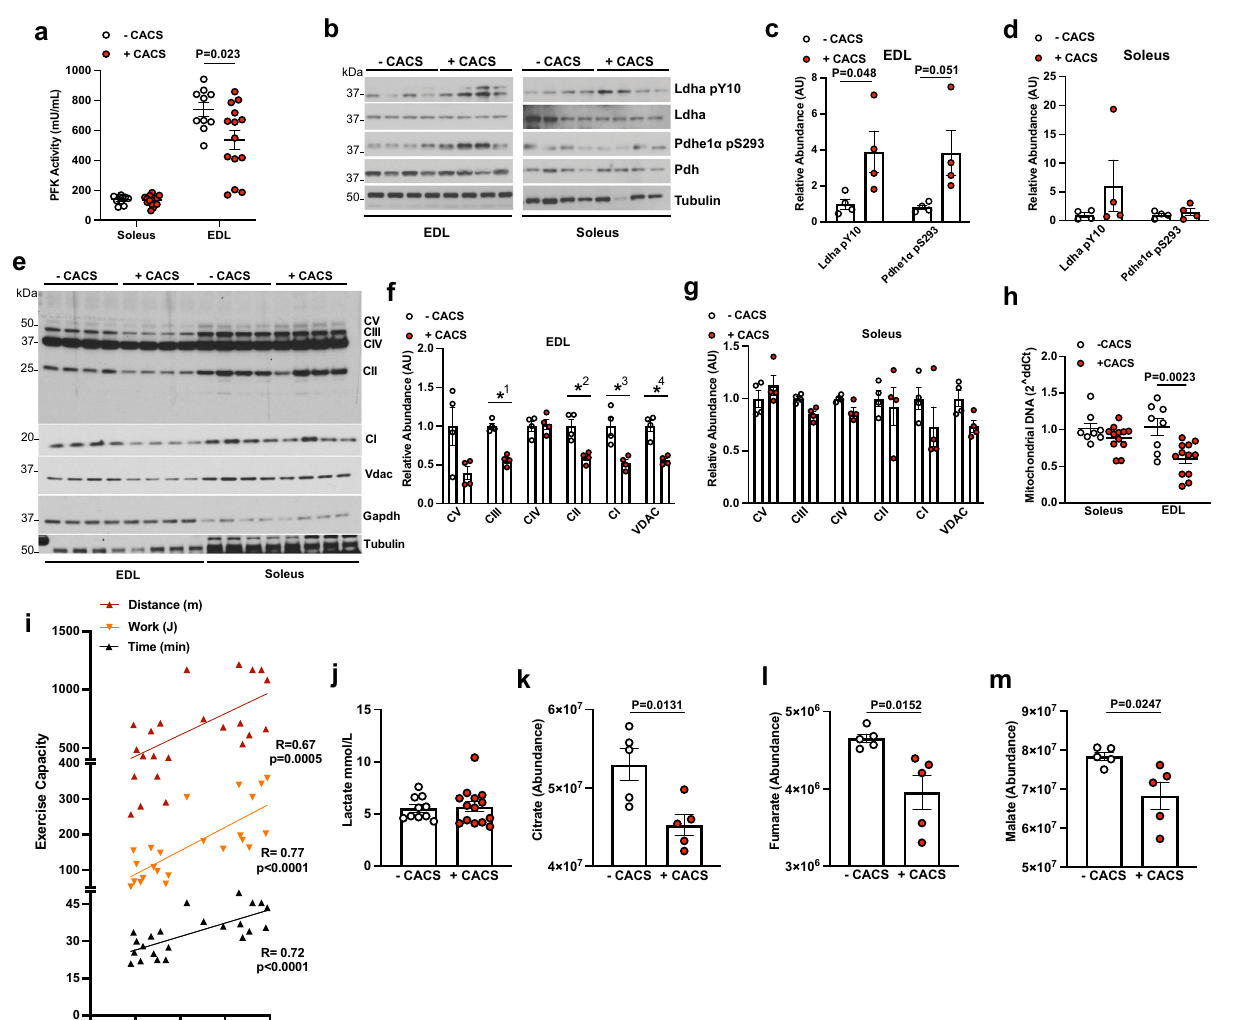
Fig. 2 | Mice with CACS have impaired skeletal muscle metabolism. a Phosphofructokinase (PFK) activity measured using Soleus lysates from mice without (-CACS, n =10) and with cachexia (+CACS, n =15) and extensor digitorum longus (EDL) lysates from mice without (-CACS, n =11) and with cachexia (+CACS, n =15). b Western blot of phosphorylated (Tyr10) and total LDHa, phosphorylated (Ser293) and total PDHe1 α , and Tubulin from Soleus and EDL lysates from -CACS and +CACS mice. c Relative quanti fi cation of WB shown in B for phosphorylated (Tyr10) LDHa and phosphorylated (Ser293) PDHe1 α in EDL lysates from -CACS ( n =4), and +CACS ( n =4)mice. d Relative quanti fi cation of WB shown in B for phosphorylated (Tyr10) LDHa and phosphorylated (Ser293) PDHe1 α in Soleus lysates from -CACS ( n =4), and +CACS ( n =4) mice. e Western blot analysis of mitochondrial oxidative phosphorylation complexes (CI-subunit NDUFB8, CII- SDHB, CIII-UQCRC2, CIV-MTCO1, and CV-ATP5A) as well as VDAC, GAPDH, and Tubulin in lysates of Soleus and EDL muscles from -CACS and +CACS mice. f Relative quanti fi cation of WB shown in E for mitochondrial oxidative phosphor- ylation complexes in EDL lysates from -CACS ( n =4), and +CACS ( n =4)